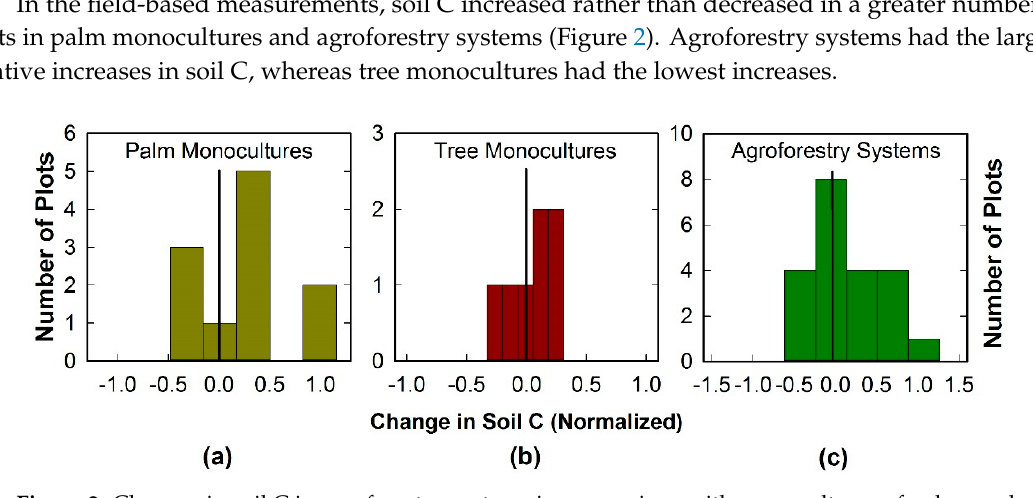
Figure 2. Changes in soil C in agroforestry systems in comparison with monocultures of palms and trees in Kerala. ( a ) Monocultures of palms (coconut and arecanut). ( b ) Monocultures of rubber trees. ( c ) Agroforestry systems. Soil (0–10 cm in depth) was sampled at two times over an 8 year period. Changes in soil C were calculated as: (Final minus Initial Soil C)/Initial Soil C.